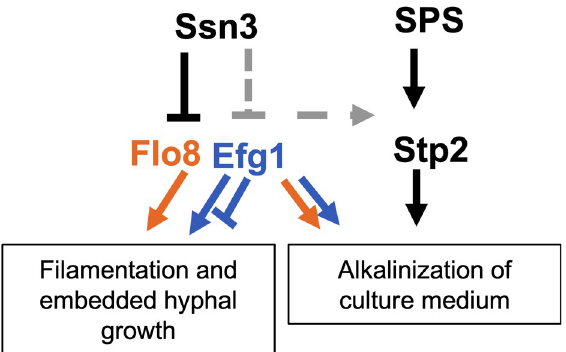
Fig 8. Summary of SSN3- centered genetic interactions revealed by this study. Hyperfilamentation of ssn3 Δ / Δ depends on Flo8 under all conditions tested including in liquid, on agar, and in embedded conditions (orange arrow). Flo8 activity in filamentation assays is tuned at T589 and S620, which were identified as sites phosphorylated by Ssn3. Efg1 plays positive roles in the hyperfilamentation of the ssn3 Δ / Δ mutant(blue arrow) but plays a negative role in filamentation in embedded conditions (blue block). Deletion of SSN3 also leads to hyperalkalinization of amino acid- rich media, and alkalinization is not required for filamentation. Alkalinization is reduced or no longer observed in ssn3 mutants lacking FLO8 , EFG1 or STP2 . Future studies will determine the mechanisms by which Ssn3 impacts metabolism through Flo8 and Efg1, if it directly modulates Efg1 levels (grey, dotted block arrow) and if Ssn3, Flo8 or Efg1 affect Stp2-dependent metabolism (grey dotted